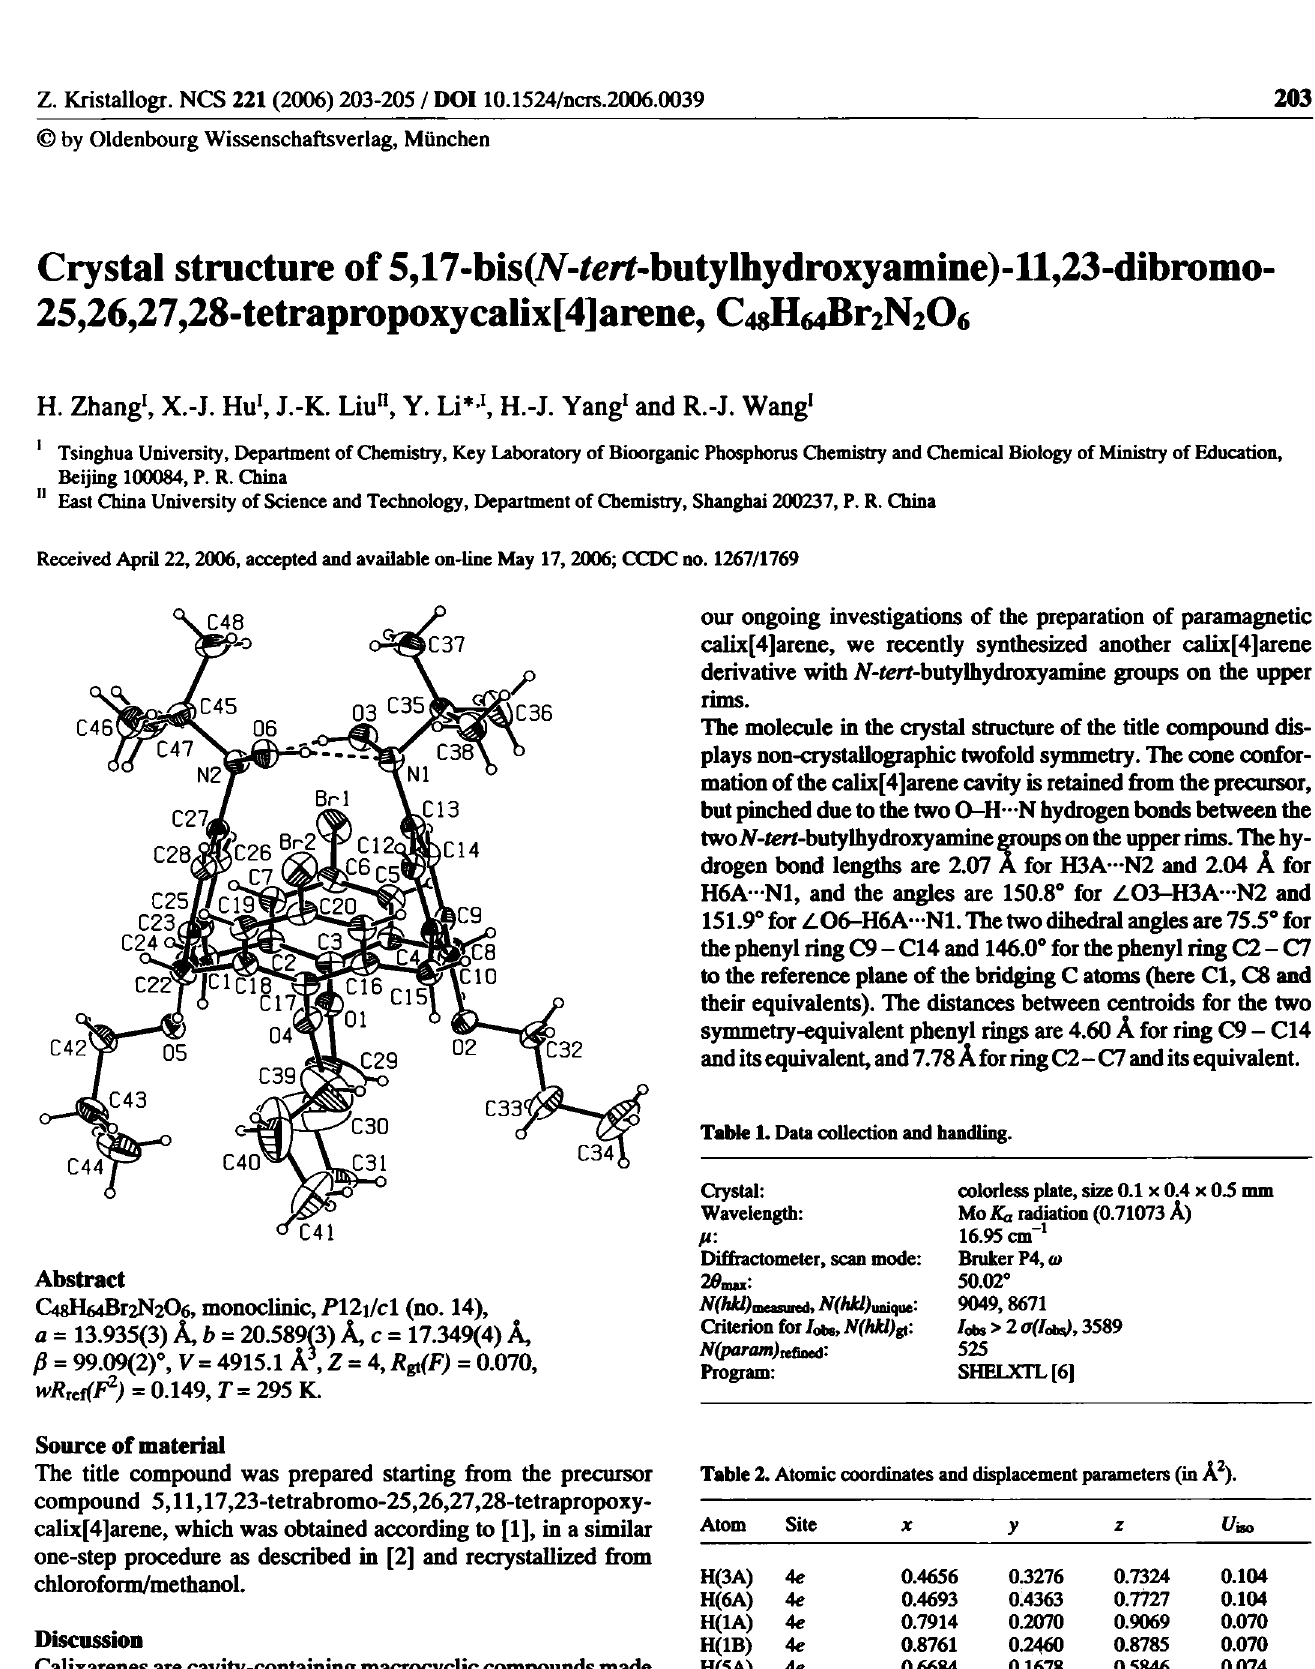
Table 2. Atomic coordinates and displacement parameters (in A 2